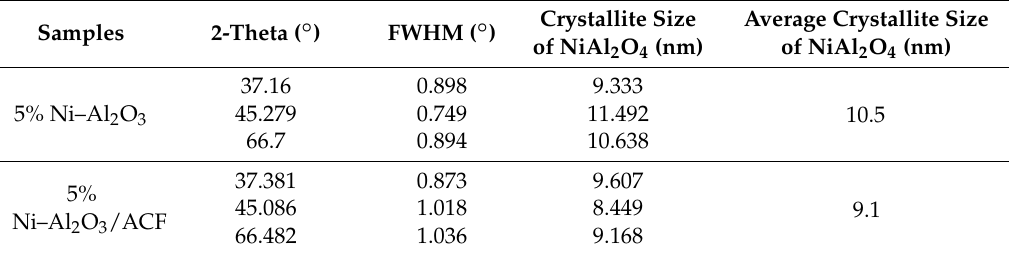
Figure 3. XRD patterns for ACF, Ni–Al 2 O 3 , and Ni–Al 2 O 3 /ACF (JCPDS cards no. 75-1621, 74-1081, and 71-1179). Table 1. Crystallite size of spinel for Ni–Al 2 O 3 and Ni–Al 2 O 3 /ACF.